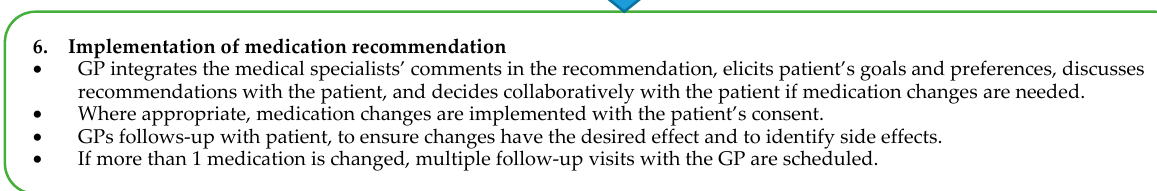
Figure 2. The Intervention: Integral Medication Control and Monitoring